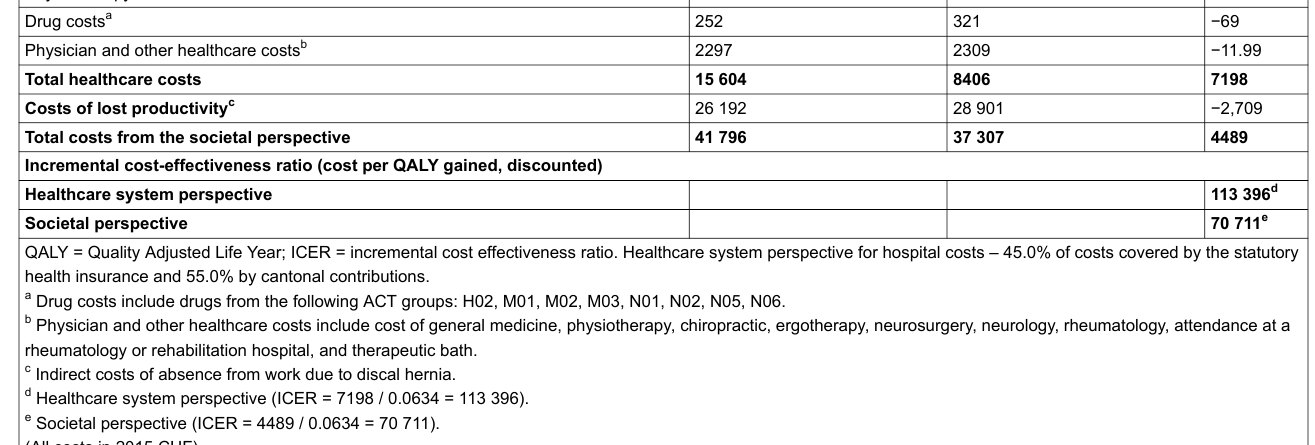
Table 2: Deterministic sensitivity analysis, comparing primarily surgical treatment (PST) with primarily conservative treatment (PCT).